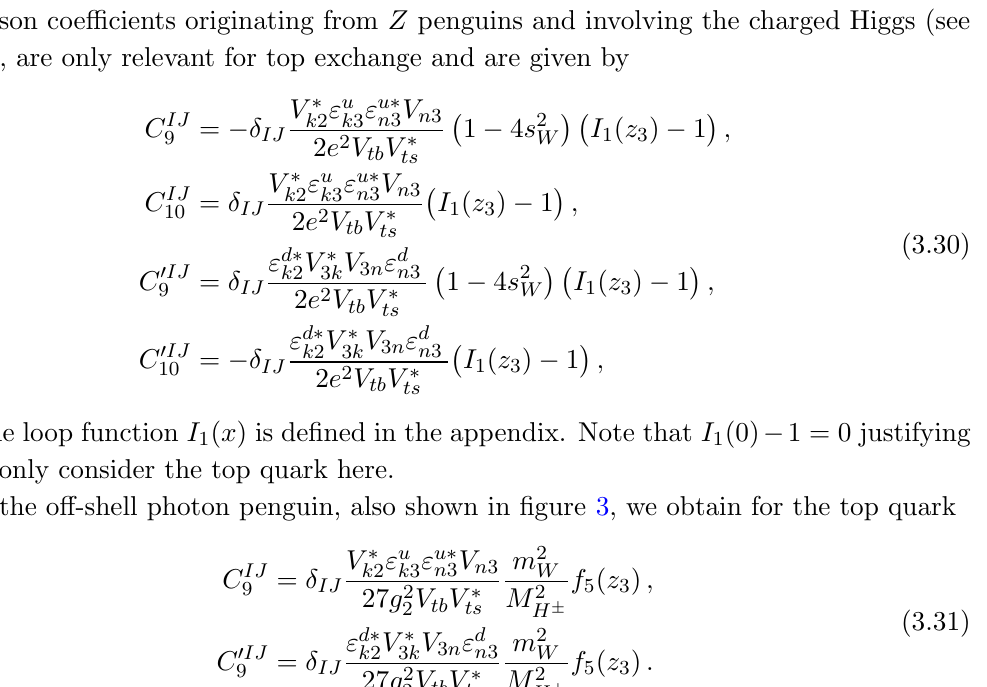
Figure 3 . Feynman diagrams showing the o(cid:11)-shell photon and Z penguin contributions to C ( 0 ) given in eqs. (3.30), (3.31),